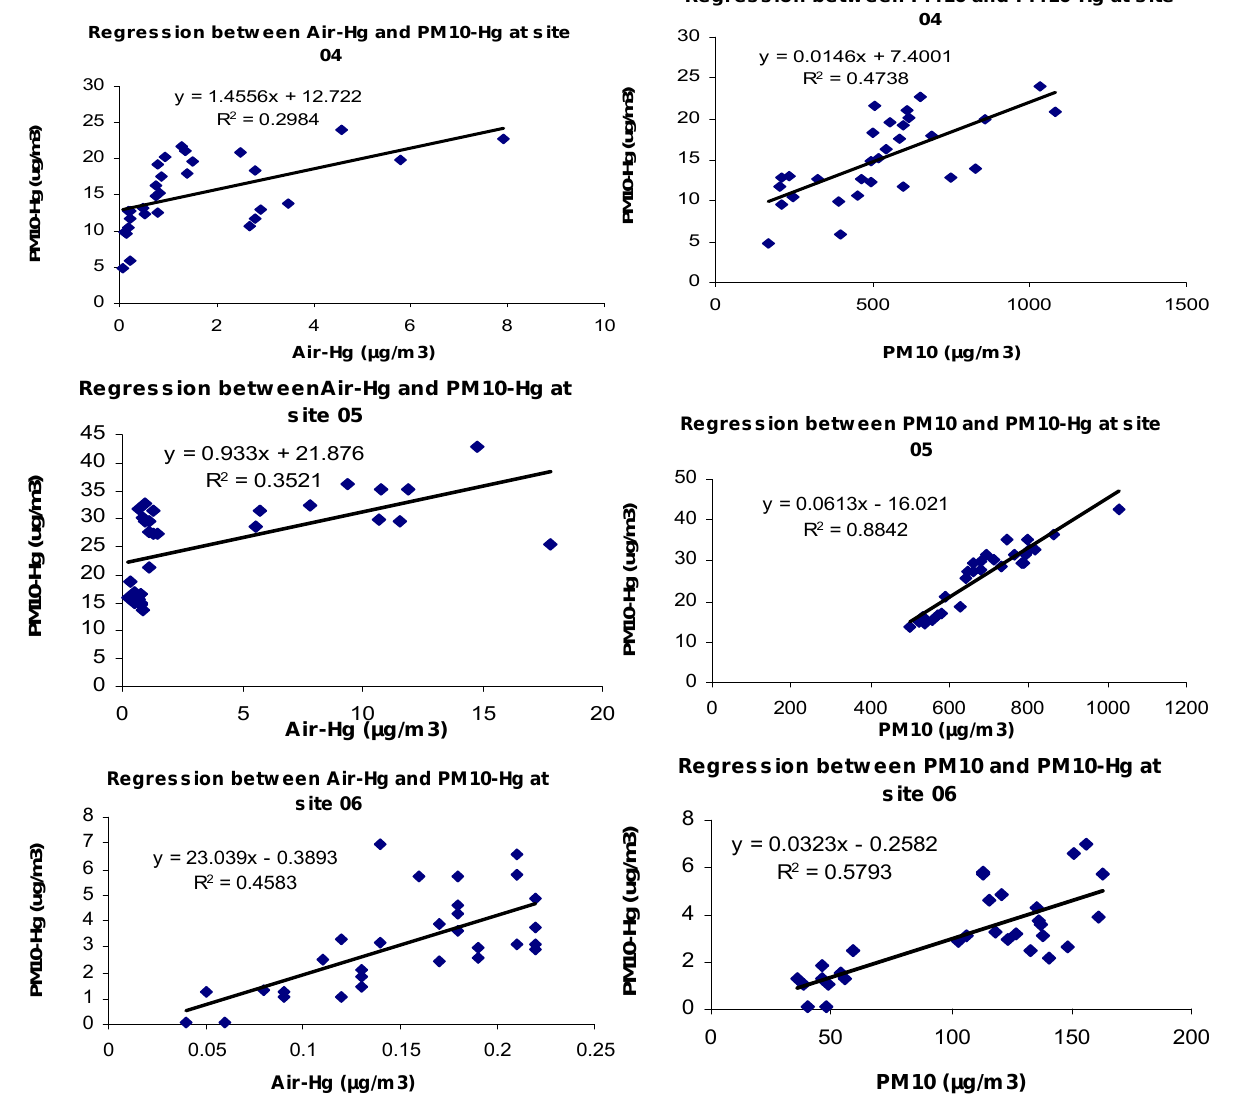
Figure 04: Regression graph of selected measurements of PM PM10-Hg and Air-Hg at identified sites around steel plant, Bhilai